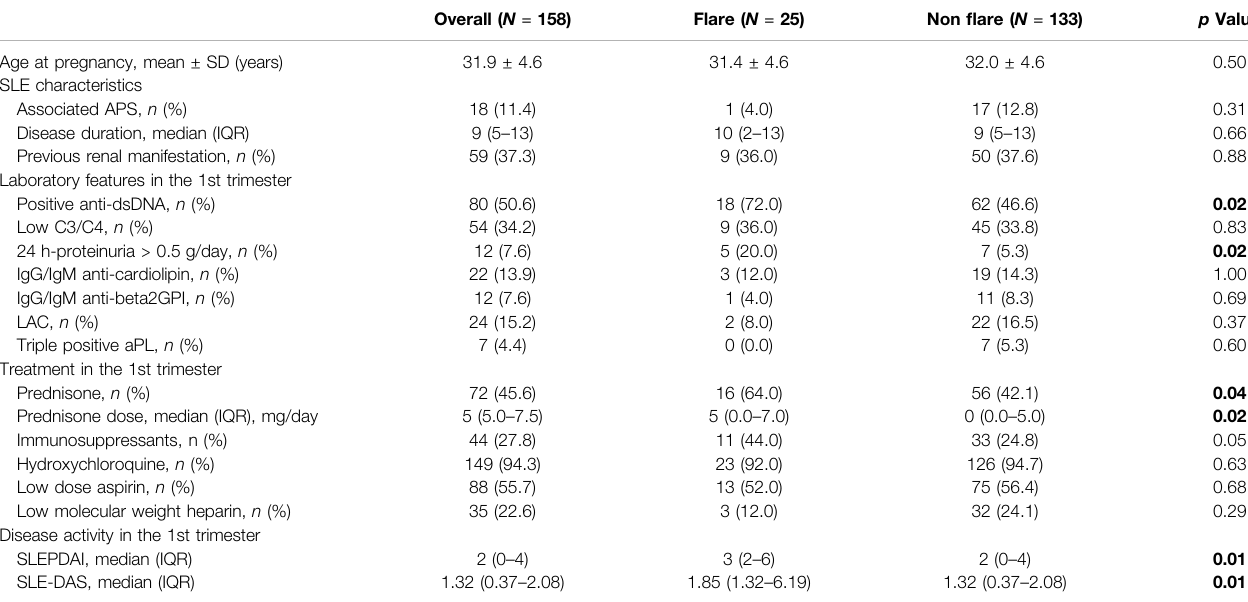
TABLE 2 | Univariate analysis: Maternal fl ares in the 2nd and 3rd trimester. Bold values refer to signi fi cative p values ( p < 0.05). Overall ( N =